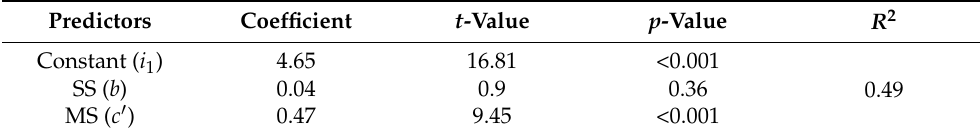
Table 3. Linear regression result using Equation (2); outcome: